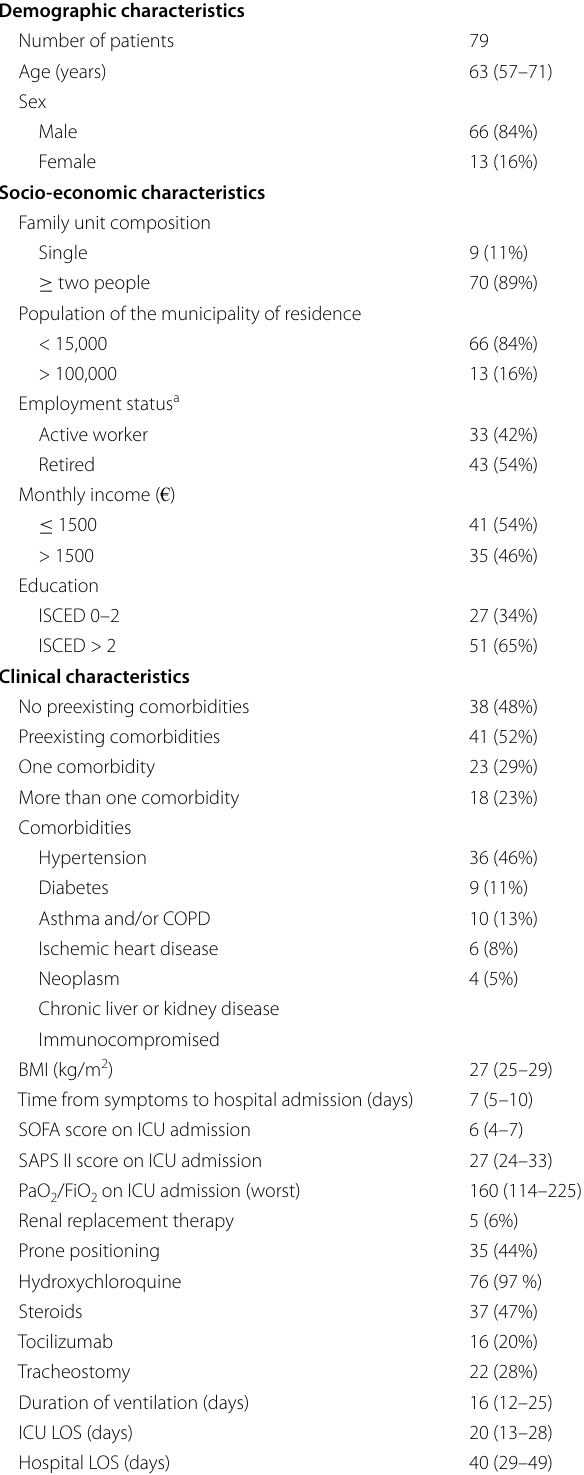
Table 1 Demographic, socio-economic, and clinical characteristics of C-ARDS survivors responding at follow-up Demographic